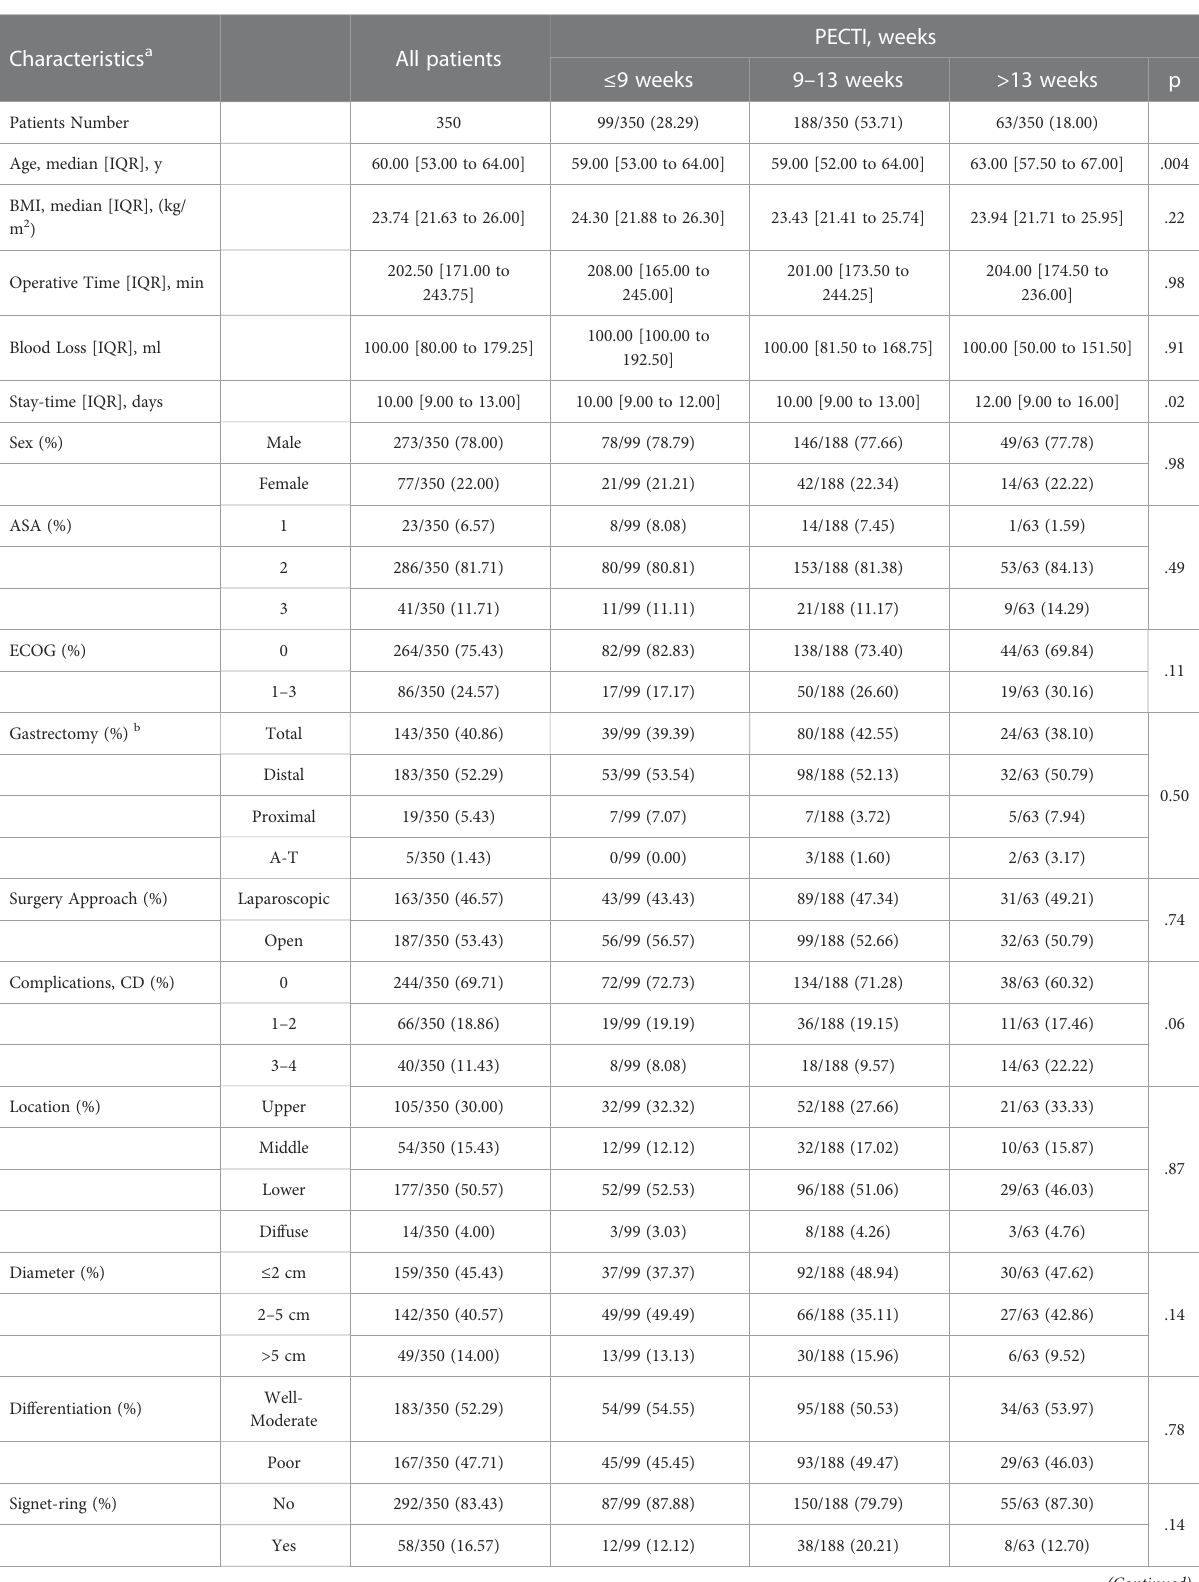
TABLE 1 Patient demography and clinicopathologic characteristics in the PECTI group.